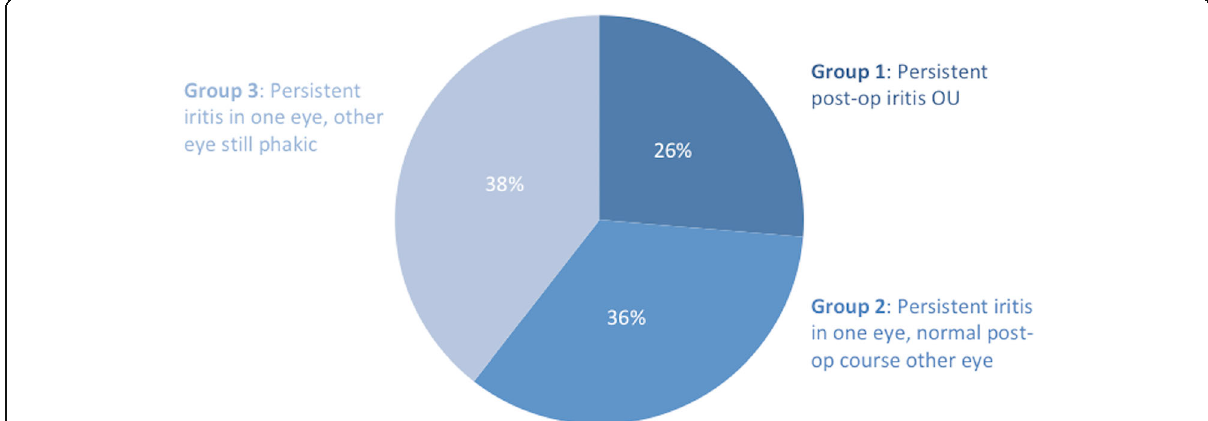
Fig. 2 Percentage of patients by group. Legend: Patients in the prolonged post-iritis group were divided into three groups based on the course of the other eye and if both eyes had undergone